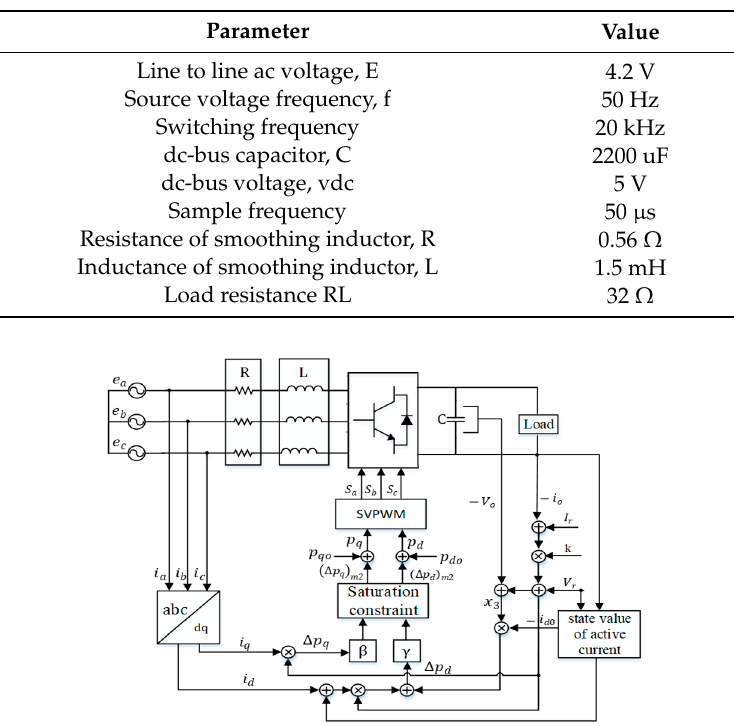
Figure 6. System diagram of the single module control of the space vector pulse width modulation method (SVPWM) rectifier.